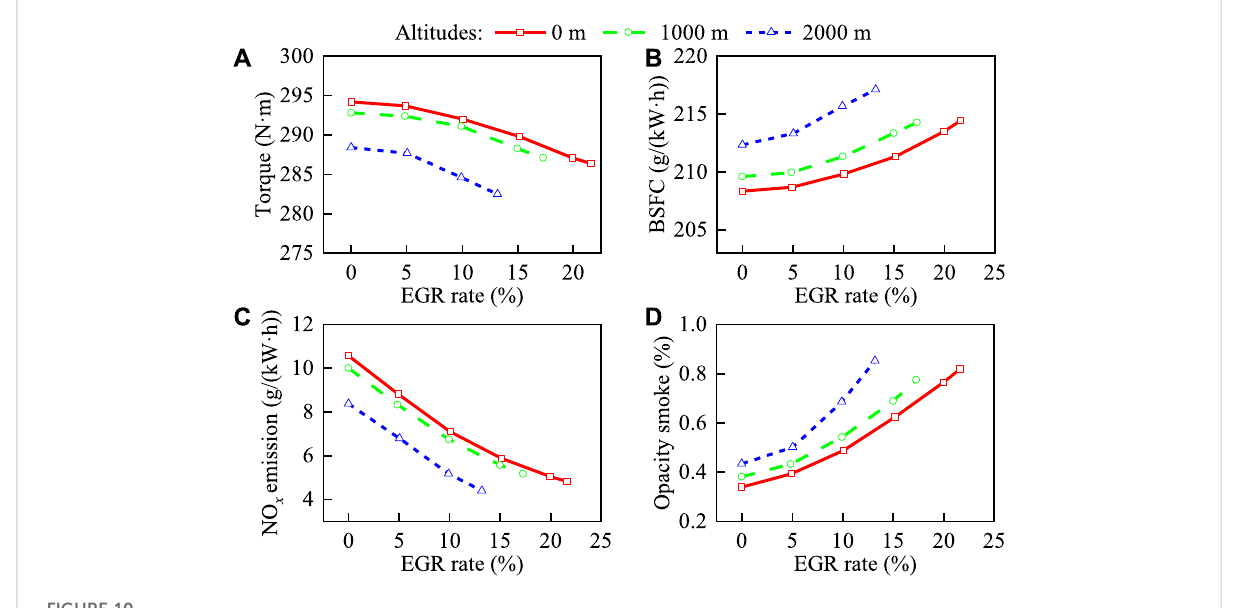
FIGURE 10 Impacts of EGR rate on engine performance and emissions, (A) torque, (B) BSFC, (C) NOx emission and (D) opacity